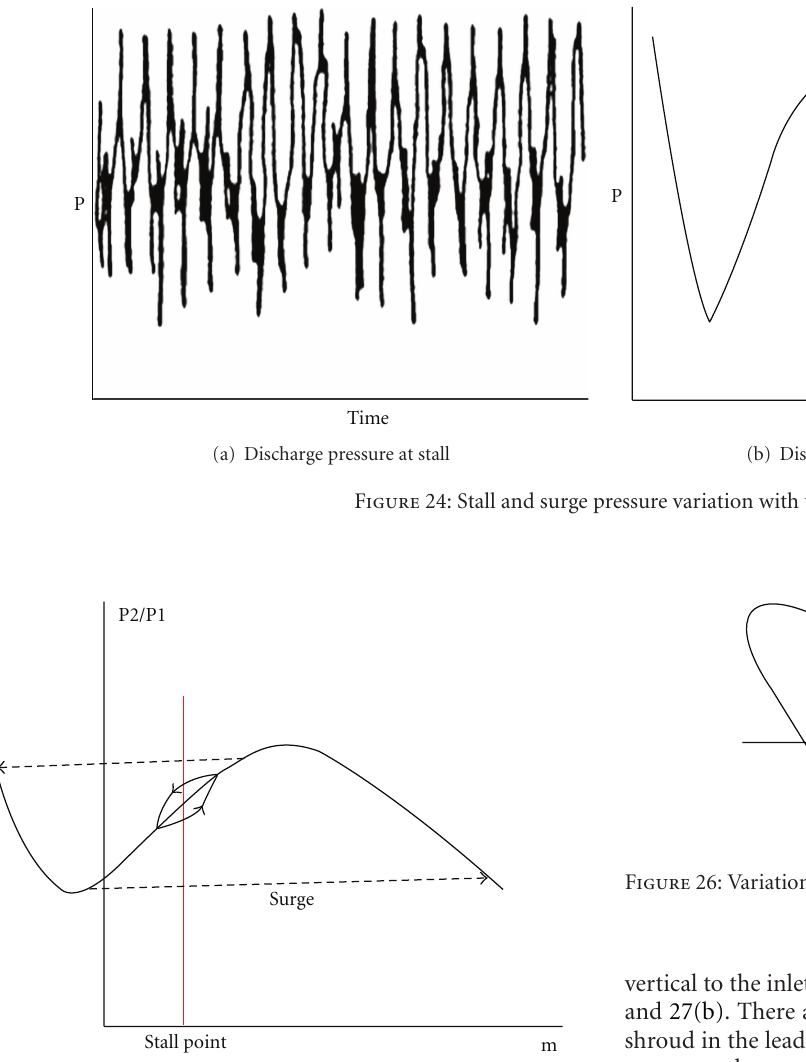
Figure 25: Surge of the centrifugal compressor.